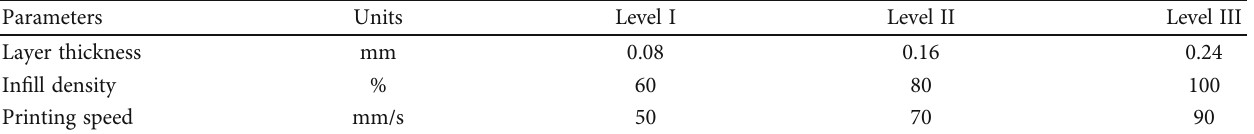
Table 1: Input parameters and their corresponding level values.